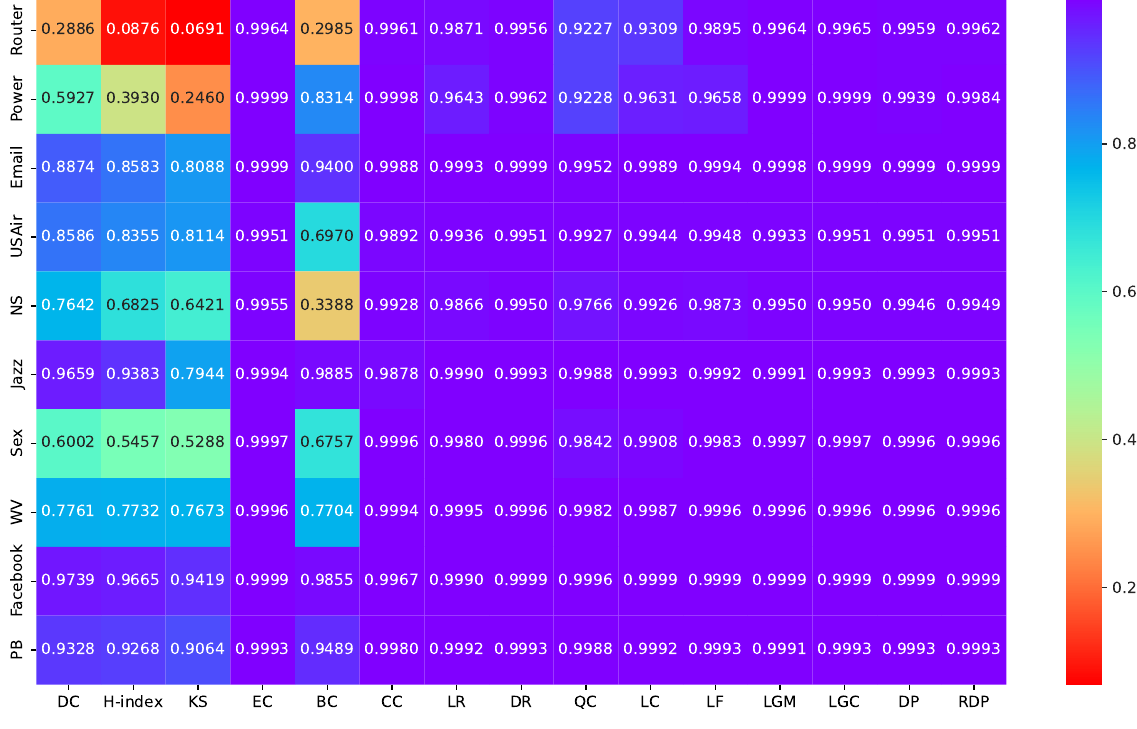
Figure 5. The monotonicity of different